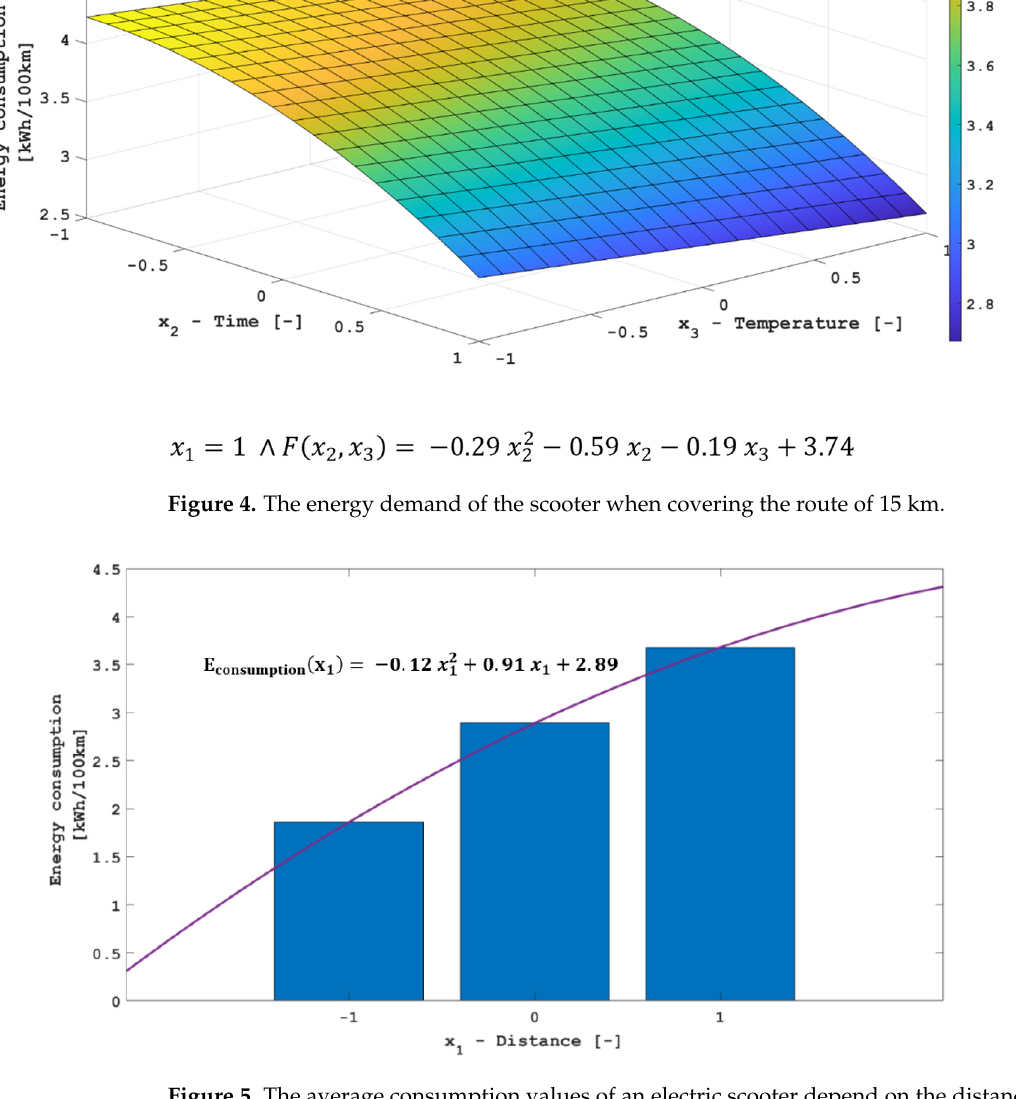
Figure 5. The average consumption values of an electric scooter depend on the distance traveled. Other aspects that affected energy consumption were temperature and